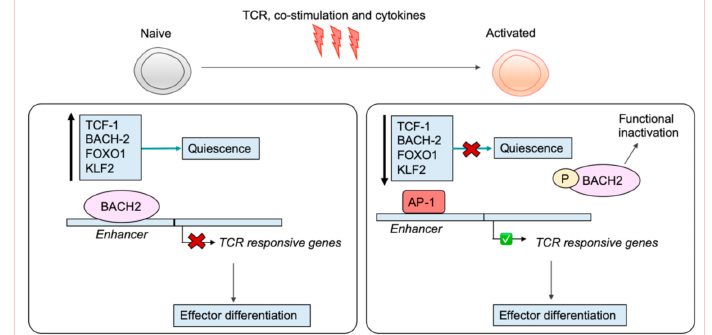
Figure 2. Key transcription factors enforce quiescence of naïve T cells. The transcription factors TCF-1, BACH2, FOXO1, and KLF2 are strongly expressed in naïve CD8 + T cells, where they exert crucial regulatory functions to uphold the naïve state. BACH2, for example, binds to enhancers, limiting